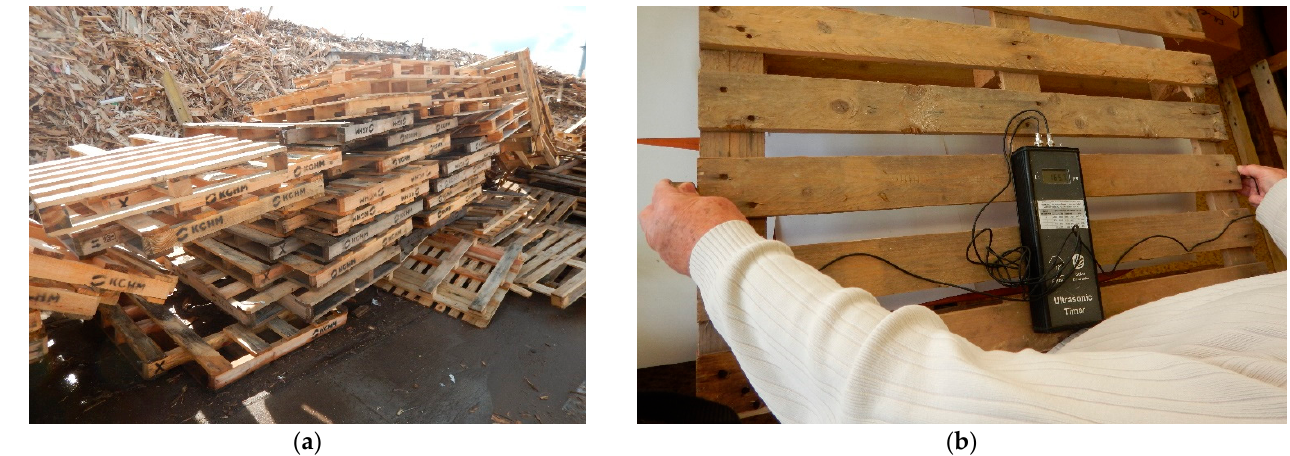
Figure 1. Views on the storage of discarded pallets in Kronospan s.r.o., Zvolen ( a ) , and on the determination of the mod- ulus of elasticity (MOE d = density × /speed of ultrasonic waves in the longitudinal direction/ 2 ) of slab in pallet by the ultrasonic timer Fakopp ( b ).